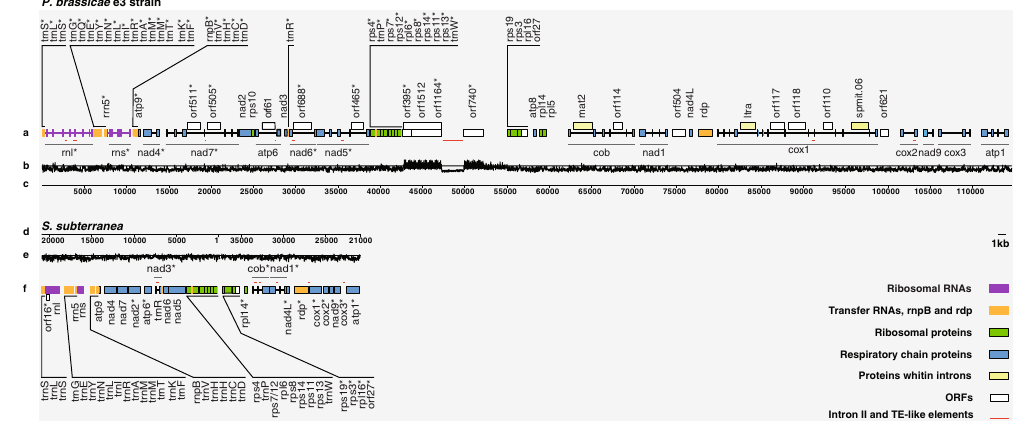
Figure 3. Physical maps and GC content of the Plasmodiophora brassicae e3 and Spongospora subterranea mitochondrial genomes. The two mitochondrial genomes have circular structure but are here linearized to facilitate comparisons. Boxes represent genes and exons separated by introns illustrated as lines. Colors correspond to specified gene functional groups. Genes transcribed from right to left have names marked with an asterisk. ( a ) Physical map of the P. brassicae e3 mitochondrial genome. ( b ) GC content of the P. brassicae e3 mitochondrial genome in non-overlapping sliding 20 bp windows. The horizontal line represents 50% GC. ( c ) Sequence coordinates of the P. brassicae e3 mitochondrial genome. ( d ) Sequence coordinates of the S. subterranea mitochondrial genome. For comparison, the S. subterranea sequence was opened at position 21,000 bp and two fragments (21,001-1 bp and 37,699–21,000 bp) were merged. ( e ) GC content of the S. subterranea mitochondrial genome in non-overlapping sliding 20 bp windows. The horizontal line represents 50% GC. ( f ) Physical map of the S. subterranea mitochondrial genome.